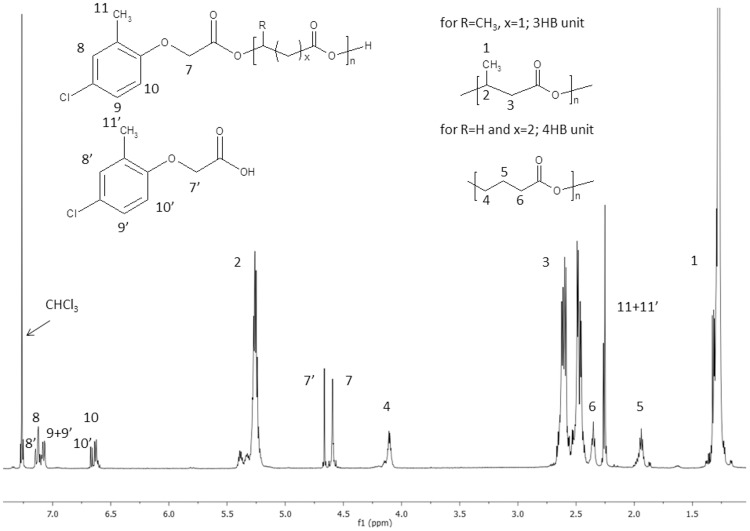
The 1H NMR spectra of sample 3 from Table 1.